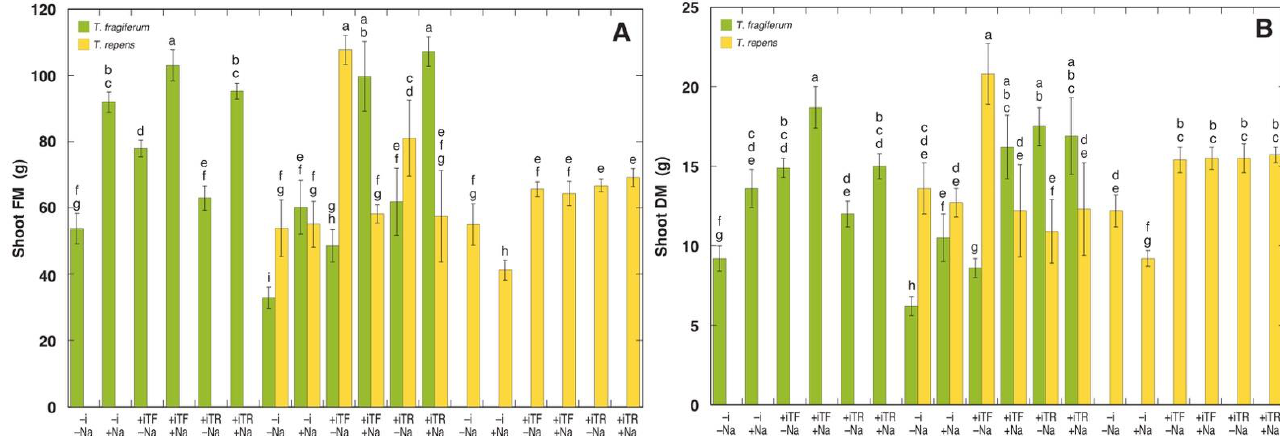
Figure 2. Shoot fresh mass ( A ) and dry mass ( B ) of T. fragiferum and T. repens plants grown in initially sterile soil. Data